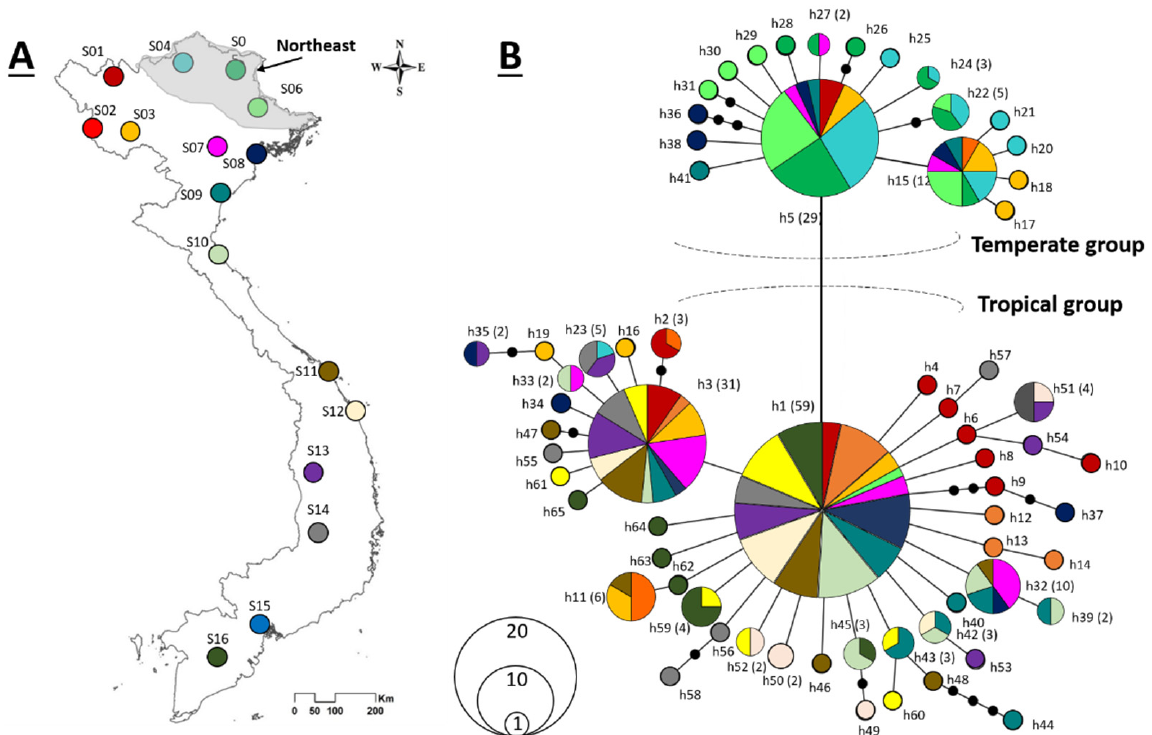
Figure 1. Map of collection localities ( A ) and phylogenetic network of COI haplotypes ( B ). ( A ) The color represents for each site matched with color in haplotype network. Codes for collection sites are shown in Table 1. ( B ) Haplotype network. Colors represent sampling localities (Table 1). Circles and colors represent haplotypes and correspond locality, respectively, and labels and numbers in parentheses indicate haplotype names and frequencies, when >1. Black dots represent intermediate haplotypes that were not recovered during the present study.